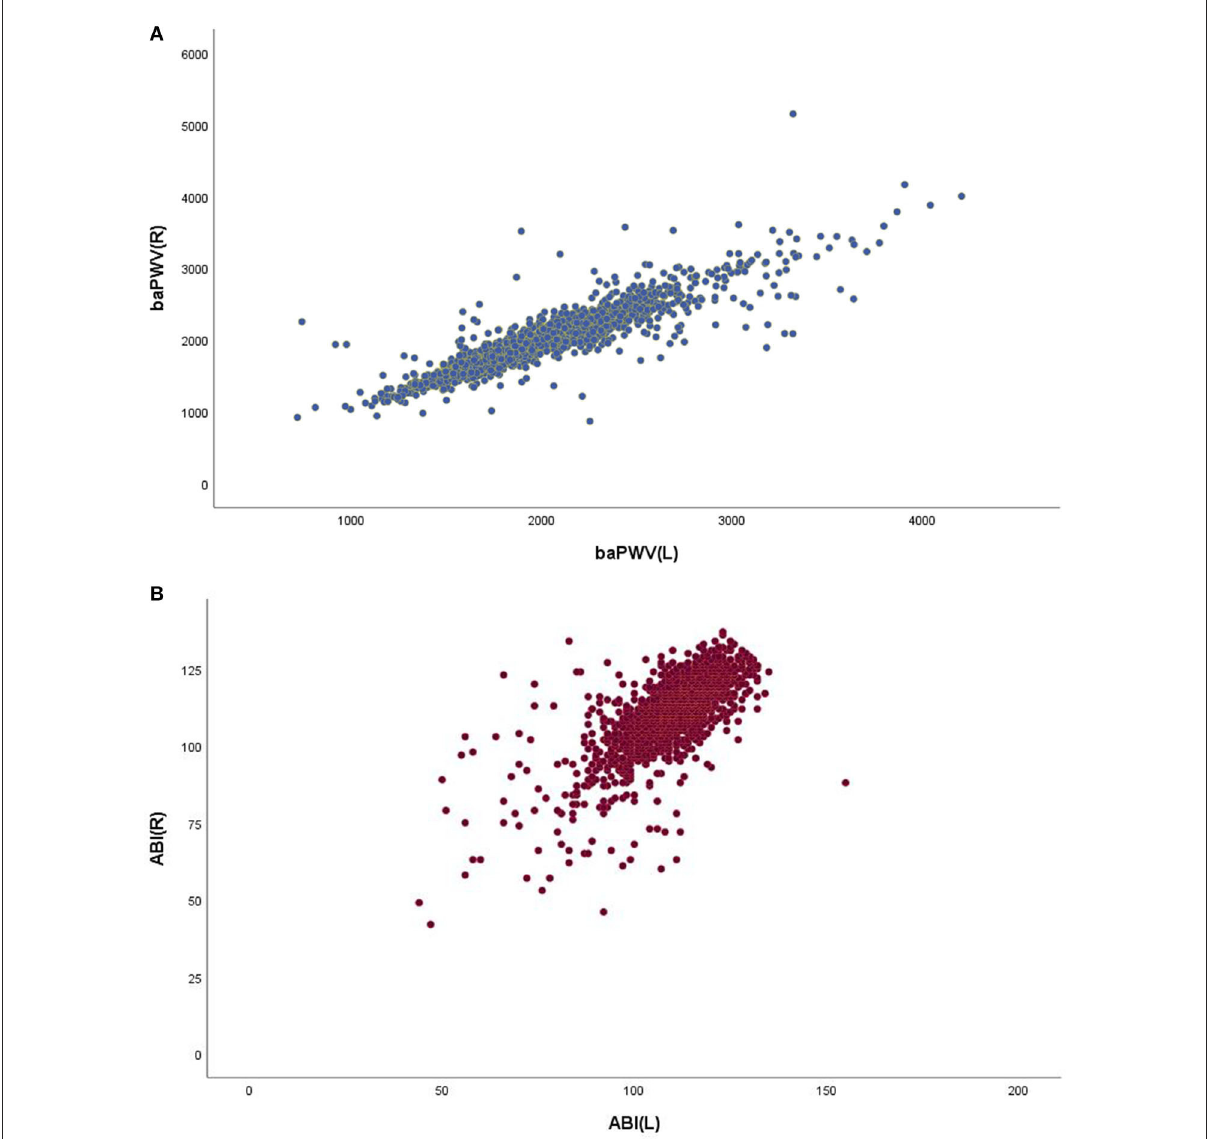
FIGURE2 Scatter diagram showing the relationship between the left/right baPWV and the relationship between the left/right ABI.